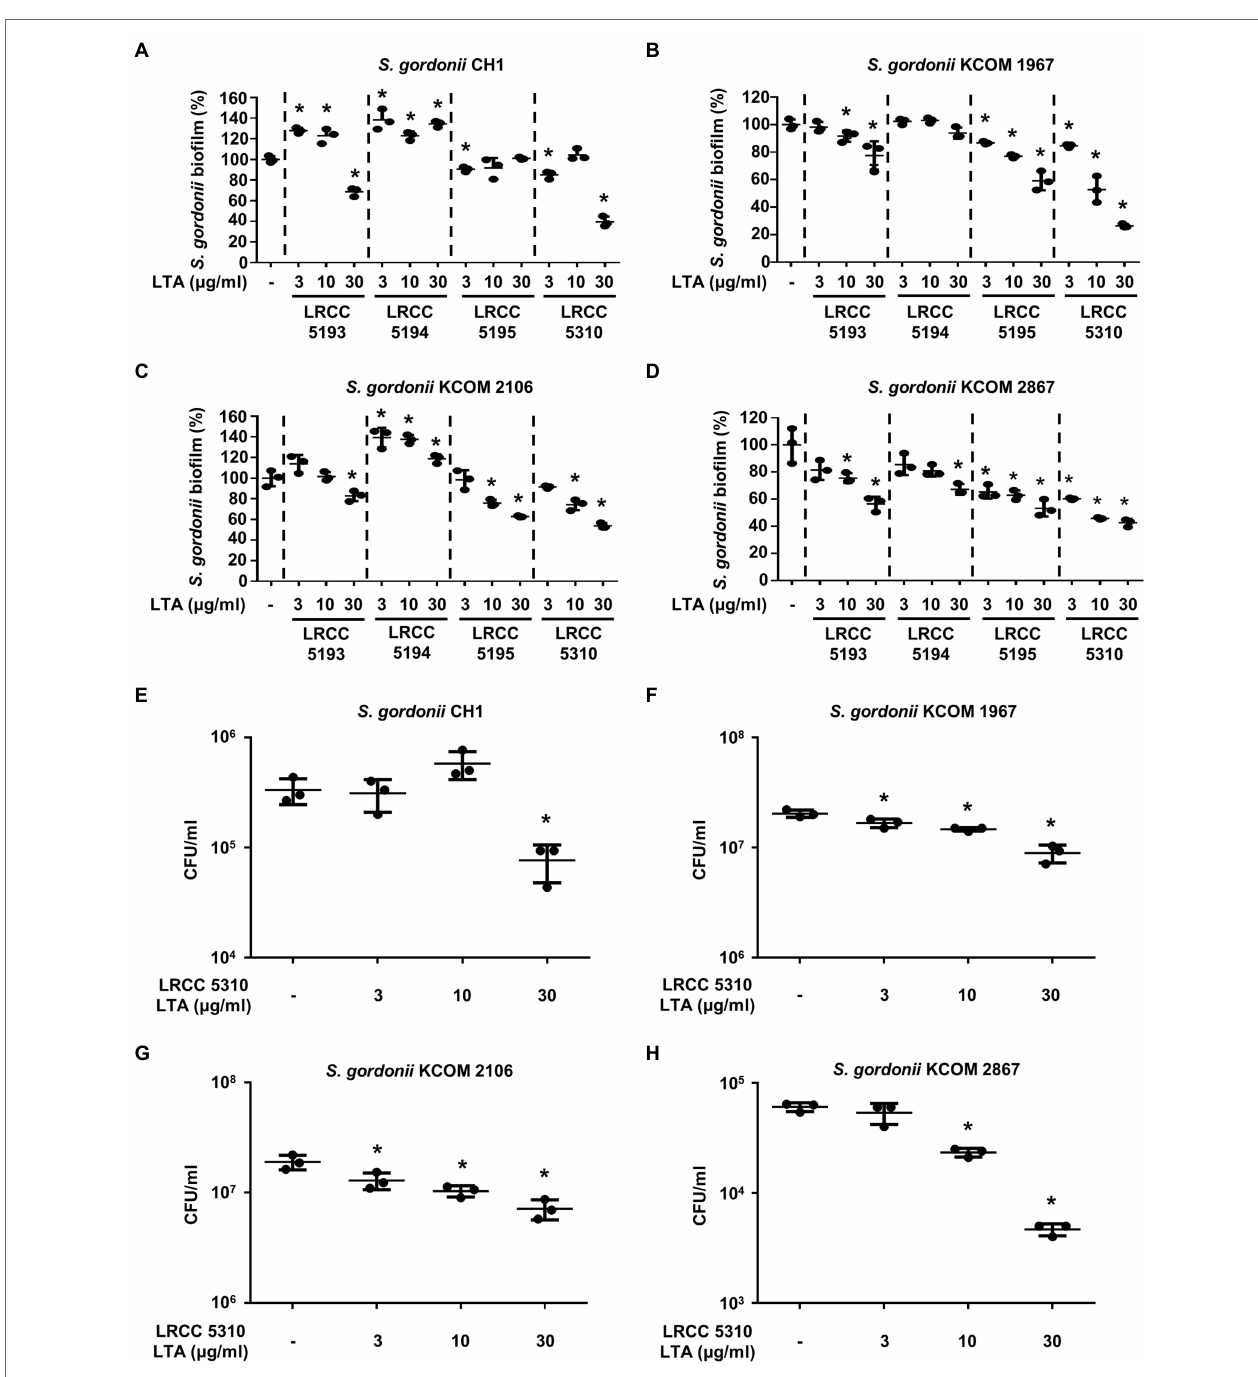
FIGURE 3 | Lp.LTAs have different anti-biofilm activity on S. gordonii . Total of four strains of S. gordonii, including (A,E) a laboratory (CH1) and (B–D,F–H) three clinically isolated strains (KCOM 1967, KCOM 2106, and KCOM 2867), were grown on 96-well plates in the presence or absence of the indicated concentrations of (A–D) various Lp.LTA or (E–H) LRCC 5310 Lp.LTA at 37 ° C for 24 h. After the incubation, biofilm formations were determined by crystal violet staining assay as described in Materials and Methods. Biofilm formation is presented as percentage change ± standard deviation of triplicates against the non-treatment group set as 100%. (E–H) After collecting the biofilm, it was serially diluted and incubated on the THY agar plate at 37 ° C for 48 h, and CFU formation was examined. Asterisk (*) indicates statistical significance at p < 0.05 between the non-treatment and each Lp.LTA treatment